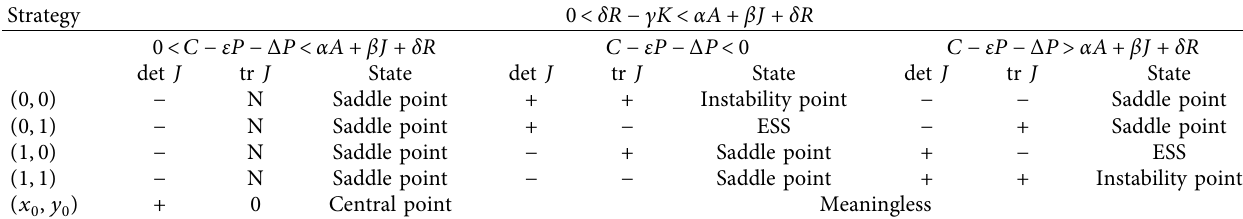
Table 3: Local stability analysis between the governments and enterprises.